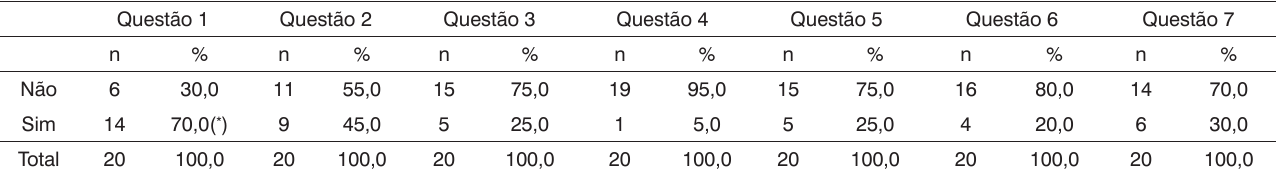
Tabela 4. Distribuição dos sinais e sintomas de DTM.